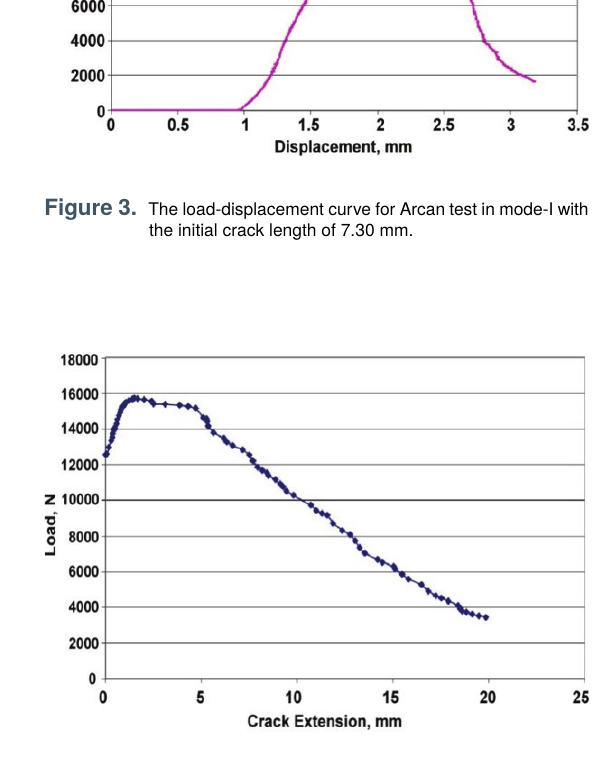
Figure 4. The load-crack extension curve for Arcan test in mode-I with the initial crack length of 7.30 mm.